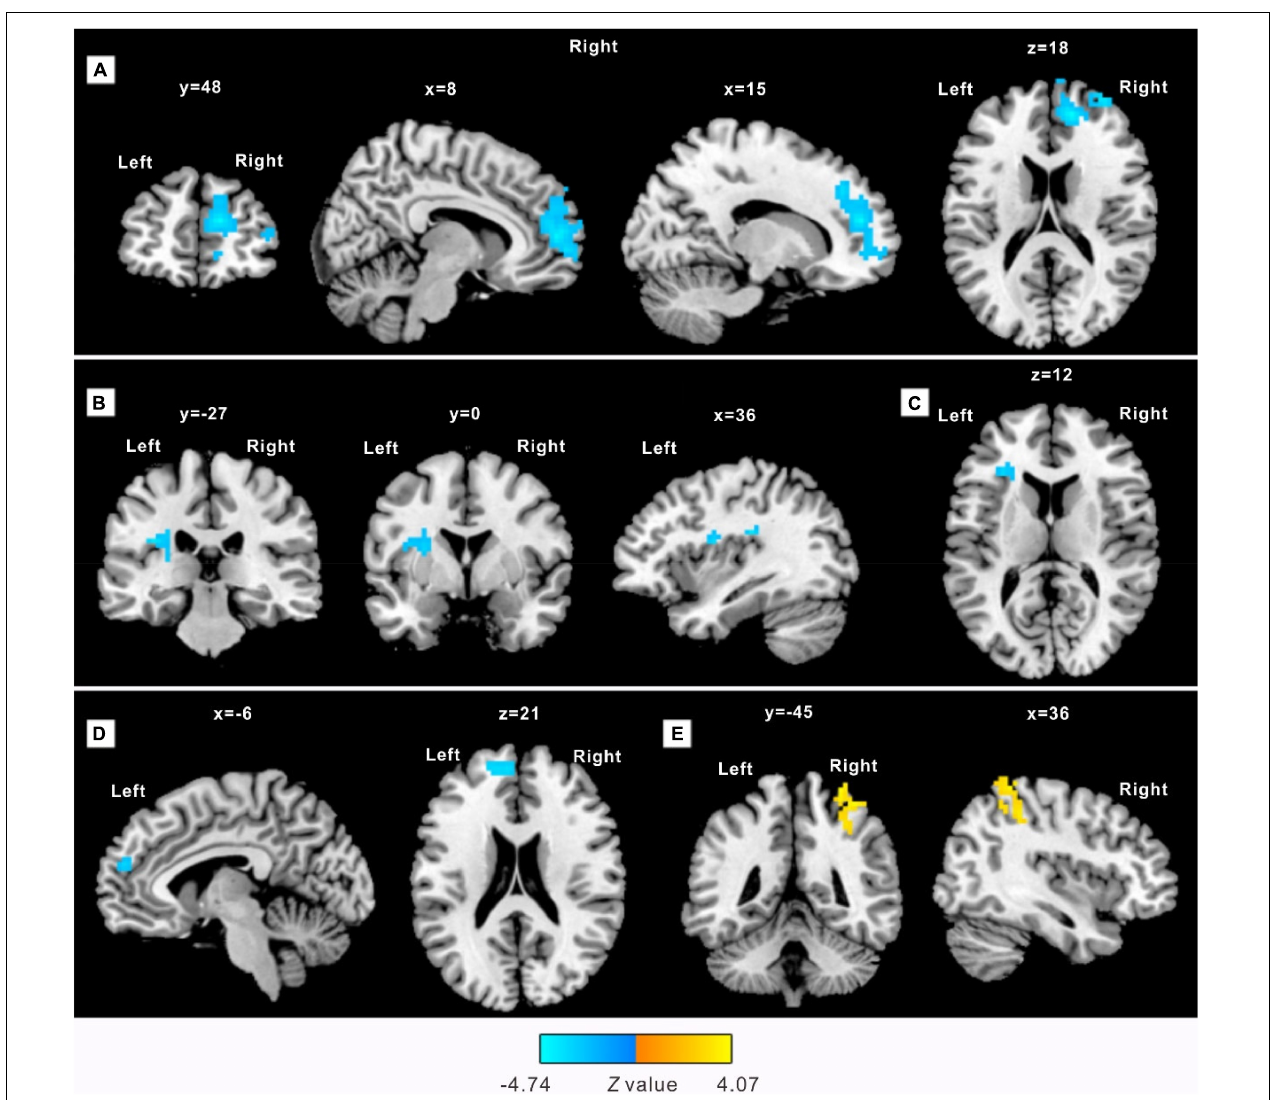
FIGURE 1 | Practitioners demonstrate a significantly different amplitude of low-frequency fluctuations (ALFF) after an 8-week practice. The clusters detected with decreased ALFF include: (A) right anterior cingulate gyrus (ACC.R), extending into the right middle frontal gyrus; (B) left posterior insula (pIC.L), extending into the left putamen; (C) left anterior insula (aIC.L), extending ventrolateral into the left middle frontal gyrus; (D) peak in the left superior medial frontal gyrus (SFGmed.L), extending into the left superior dorsolateral frontal gyrus. A cluster located in the right postcentral gyrus (PostCG.R) extending into the right superior parietal gyrus (E) showed increased ALFF. Sections are shown in sagittal, axial, and coronal planes with Montreal Neurological Institute (MNI) coordinates of the selected sections representing the peak in the x -, y -, and z-